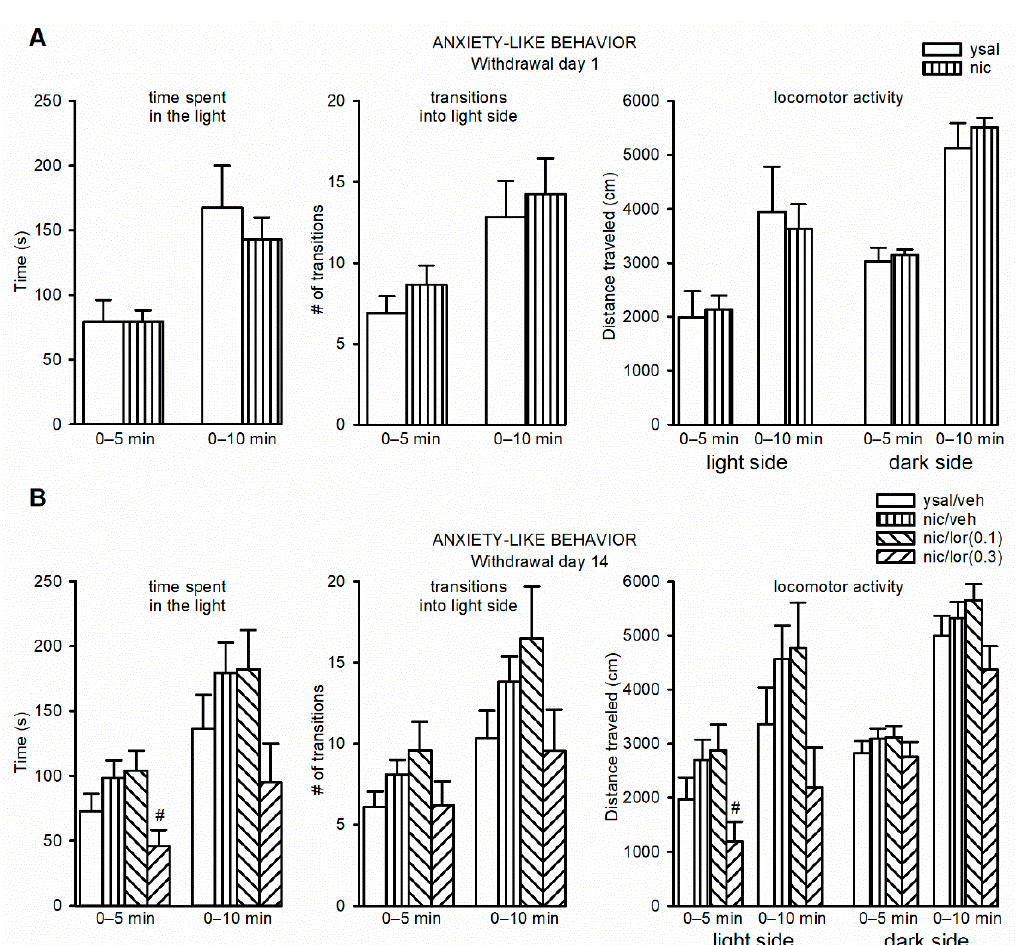
Figure 2. Anxiety-like behavior in the light/dark box test (LDB) in rats withdrawn from nicotine. ( A ) Effects of early with- drawal (day 1) from nicotine (nic) on anxiety-related behavior. ( B ) Effects of chronic exposure to lorcaserin (0.1–0.3 mg/kg, lor(0.1)/(0.3)) on anxiety-like behavior during nicotine withdrawal (day 14). The data are expressed as the means (± SEM). ( A ) ysal: n = 12; nic: n = 29, ( B ) ysal/veh: n = 12; nic/veh: n = 11; nic/lor(0.1): n = 10; nic/lor(0.3): n = 9. ( B ) # p < 0.05 versus nic/veh.